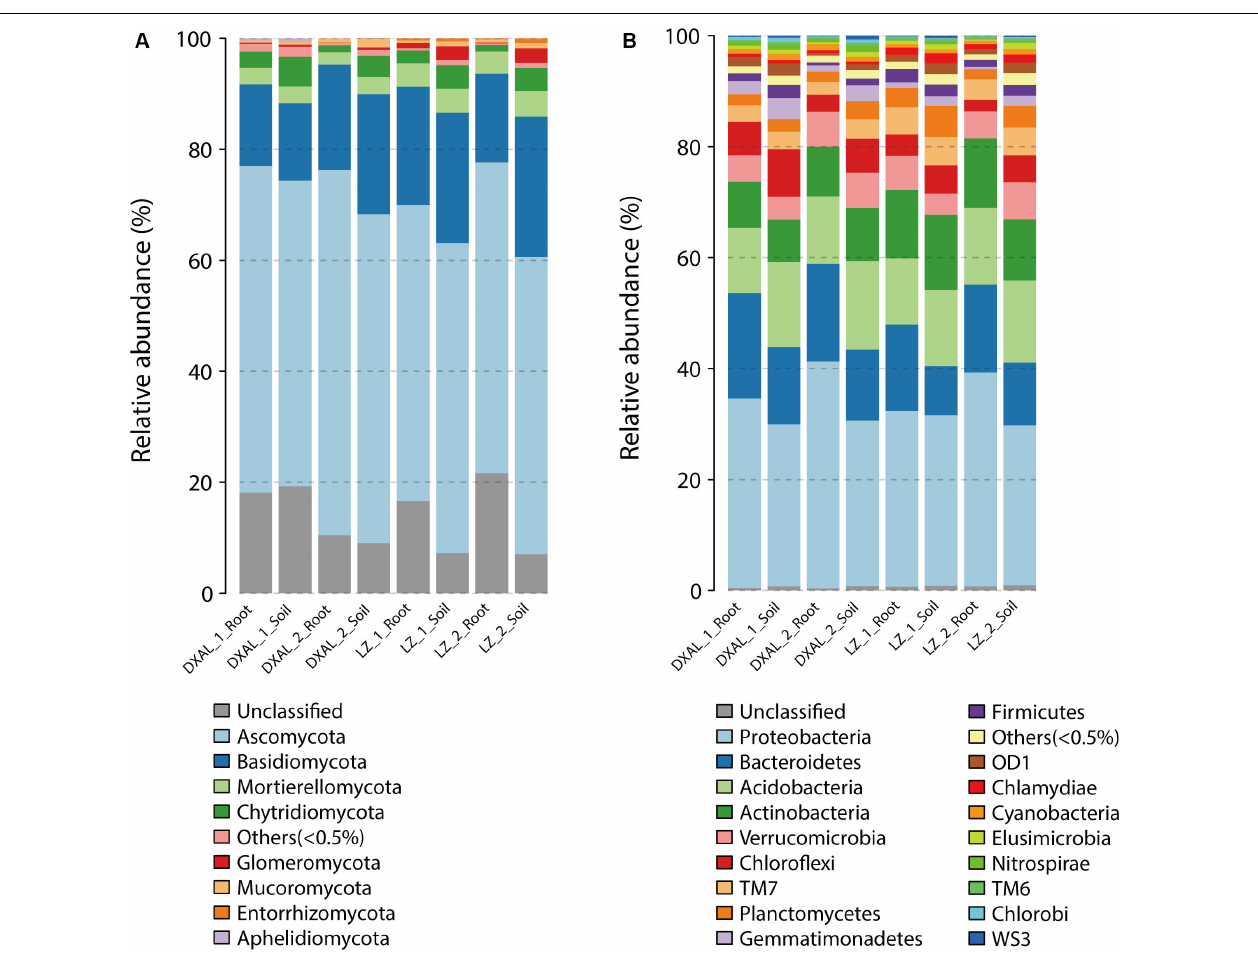
FIGURE 3 | Microbial community composition among different sample types of G. conopsea at phylum level. (A) Relative abundance of fungal taxa of each group. (B) Relative abundance of bacterial taxa of each group. DXAL: Greater Khingan Mountains, LZ: Linzhi, 1: vegetative growth stage, 2: reproductive growth